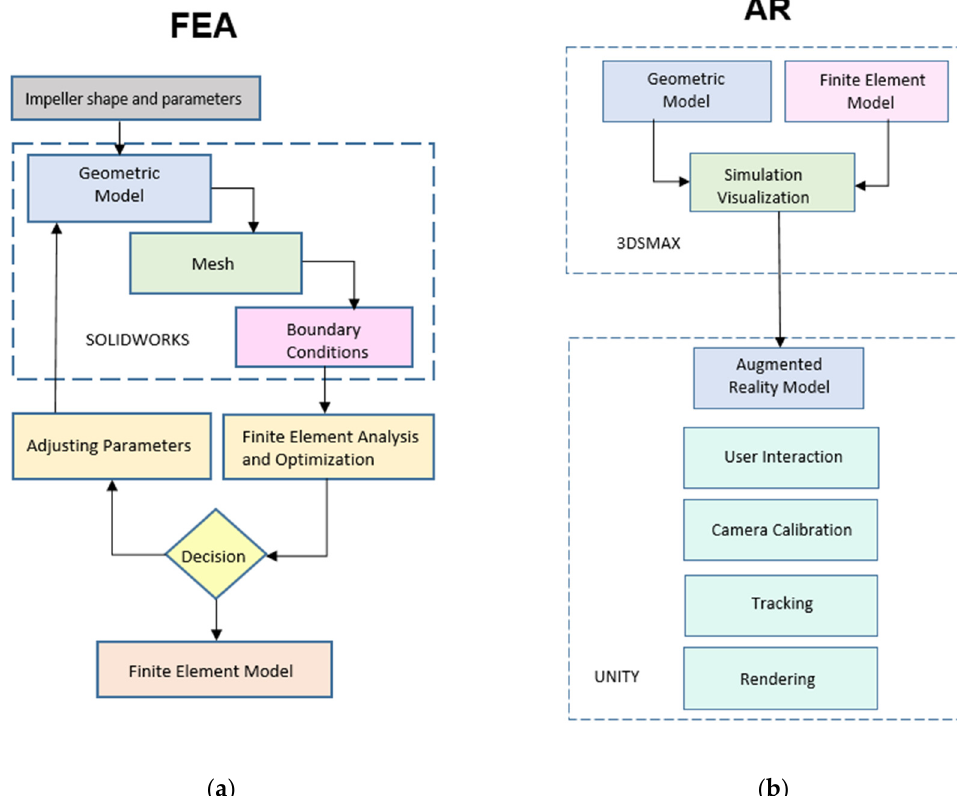
Figure 4. ( a ) Finite element analysis workflow; ( b ) Data visualization and Augmented Reality